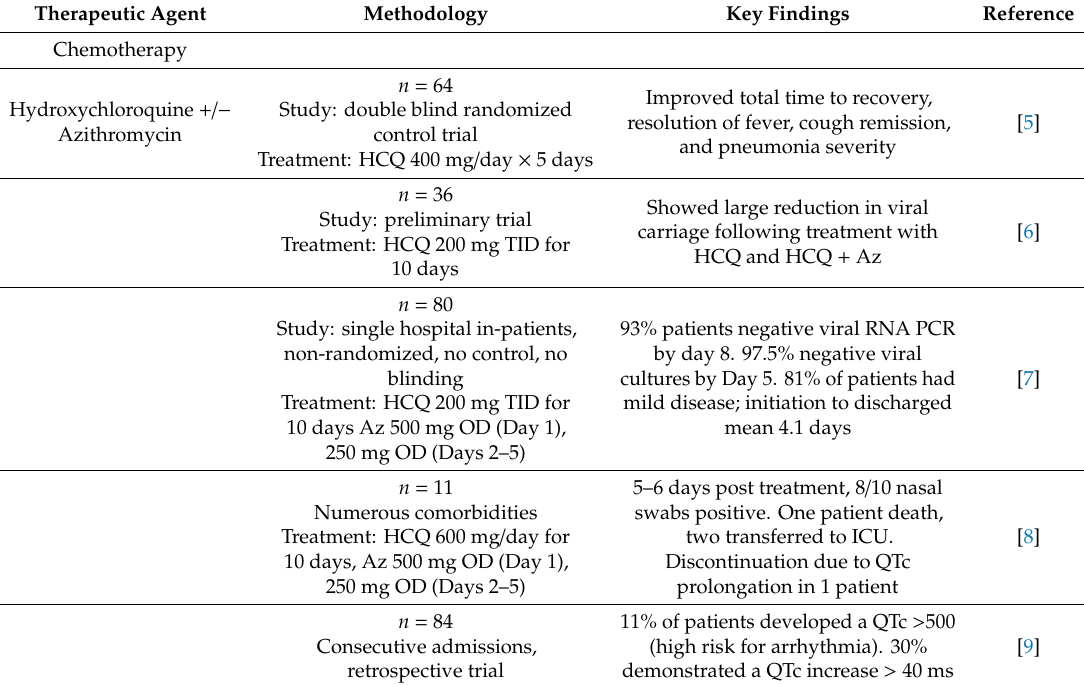
Table 1. Description of the studies using different types of therapeutic agents. Figure 1. Number of publications reviewed in this review.